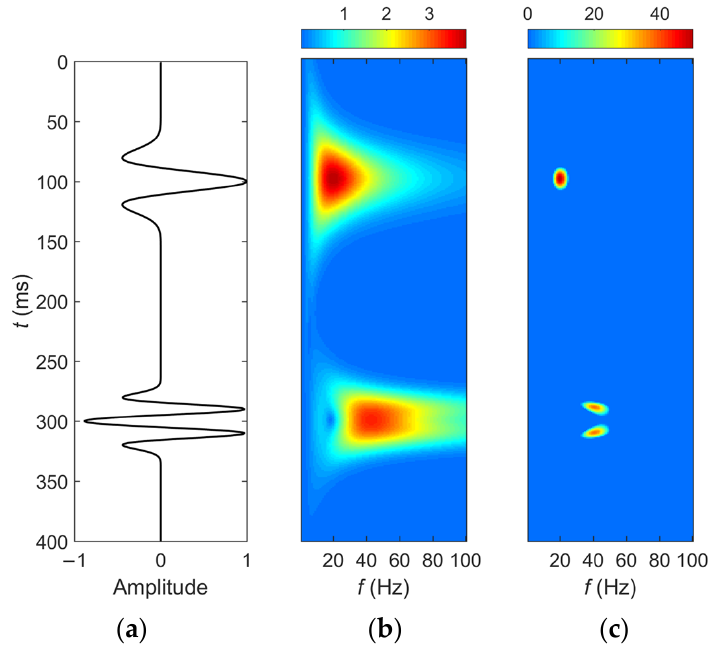
Figure 1. ( a ) Synthetic signal and the corresponding time ‐ frequency spectra calculated using ( b ) CWT and ( c ) ISD method, respectively.